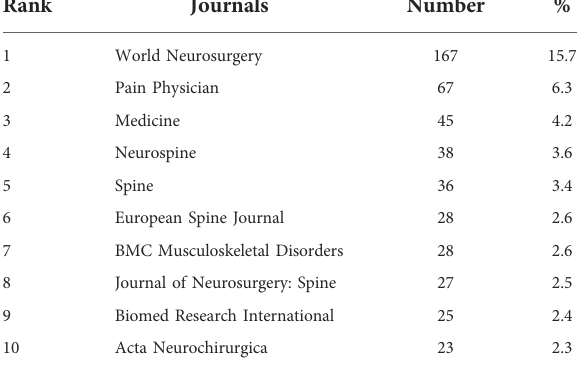
TABLE 3 Top 10 journals in the FESS fi